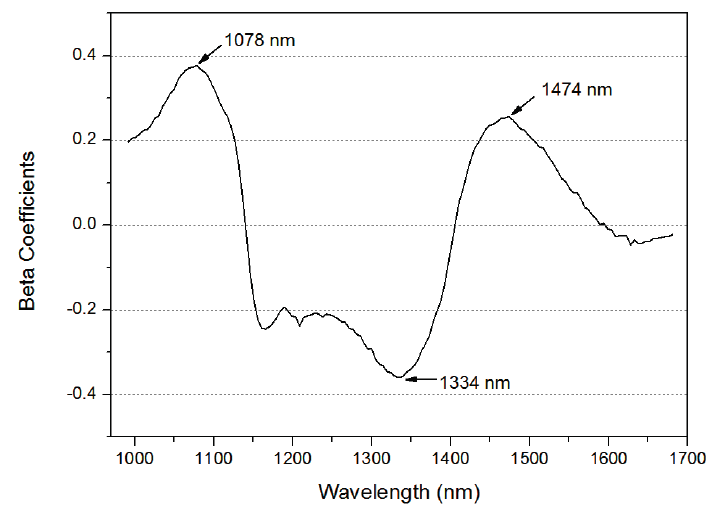
Figure 7. The beta coefficients of the re-developed PLS-DA